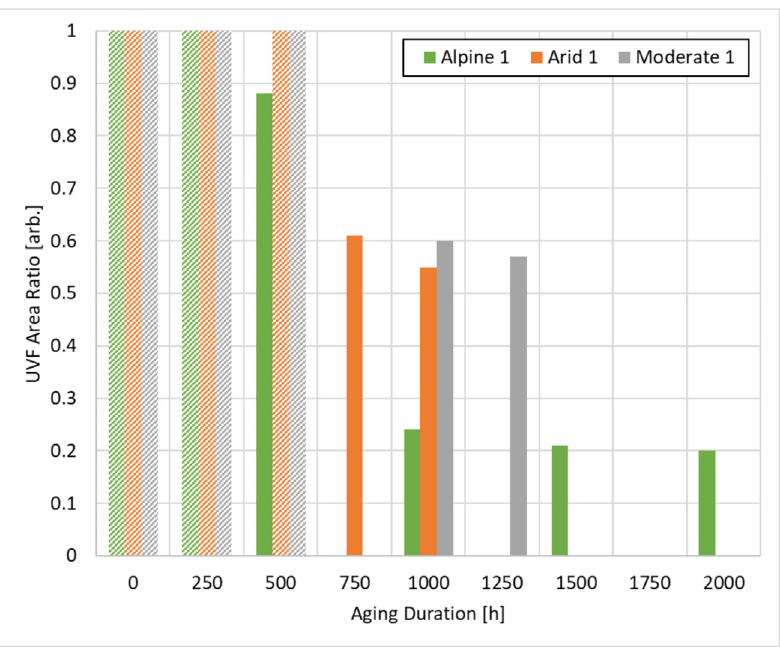
Fig. 9. UVF area ratio analysis for accelerated aging procedures of Alpine 1, Arid 1 & Moderate 1.